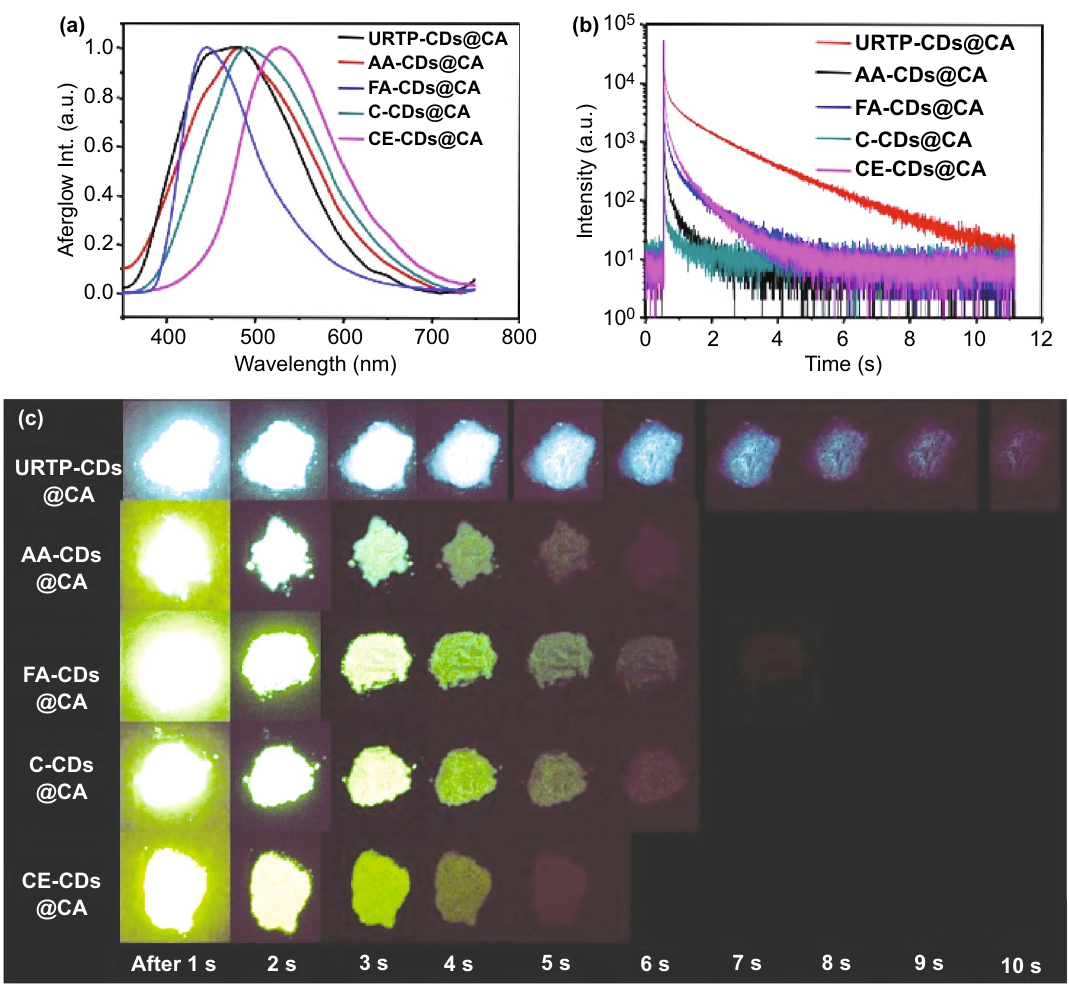
Fig. 5 a Normalized afterglow emission spectra of various kinds of CDs@CA composites; b the afterglow decay spectra of various kinds of CDs@CA composites; c photographs of various kinds of CDs@CA composites in solid state after ceasing the 365 nm UV irradiation (1–10 s) under ambient